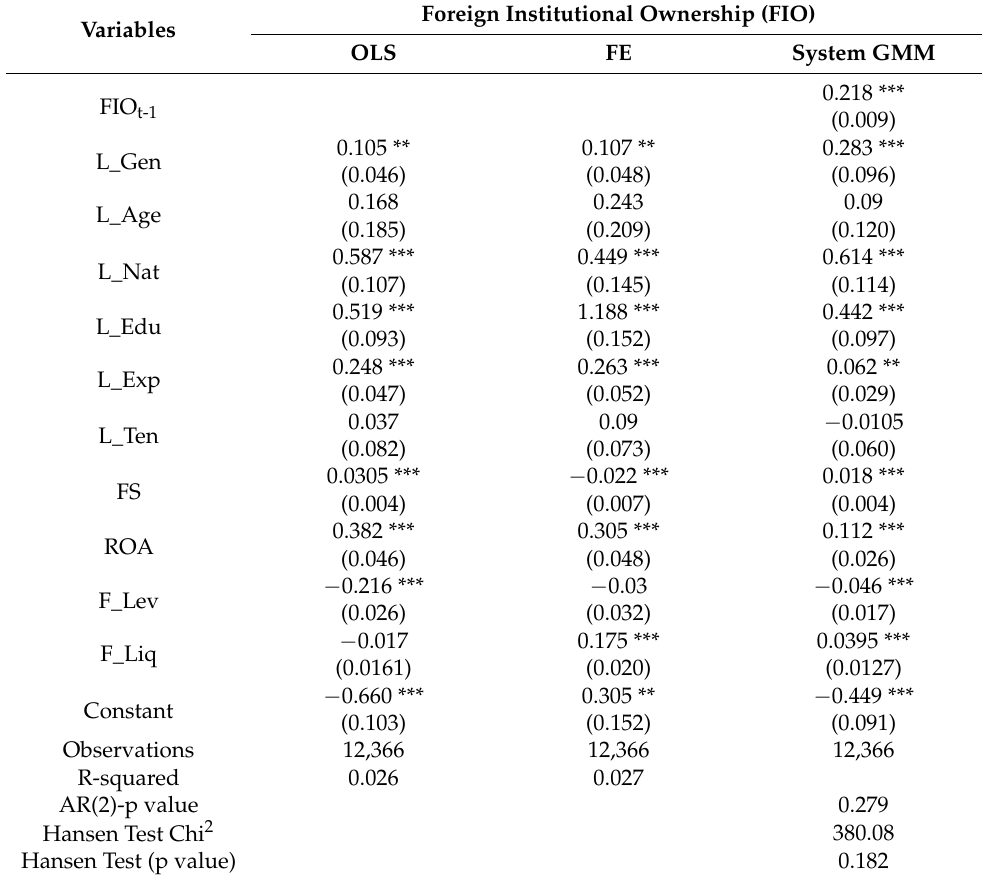
Table 3. The results of the OLS, FE, and System GMM regression